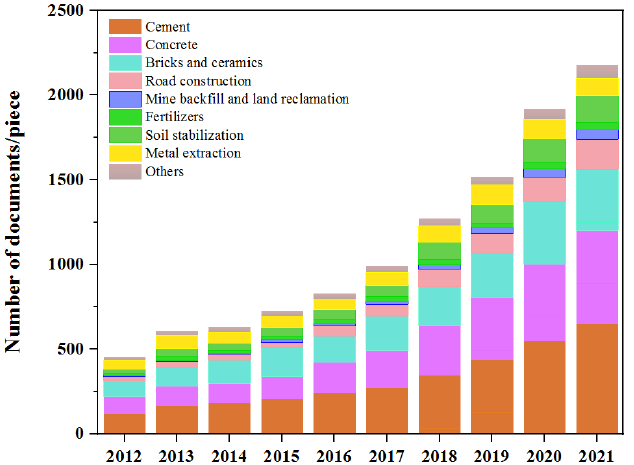
Figure 1. Statistics of relevant literatures on the CFA utilization from 2012 to 2021 (Data come from the core collection of Web of science).